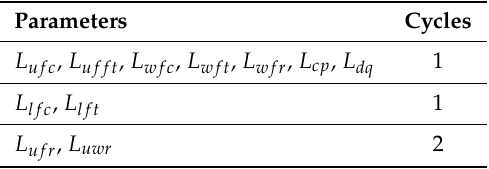
Table 3. Actual value of parameters in our